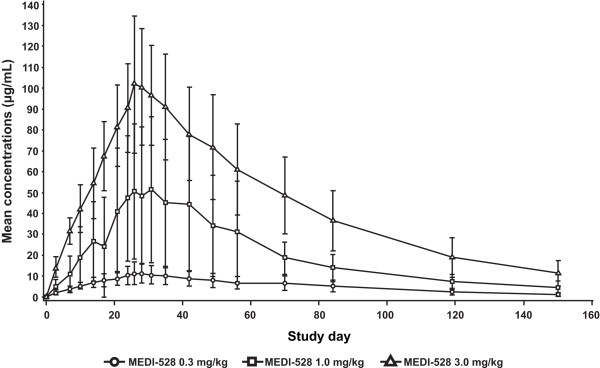
MEDI-528 mean serum concentrations in study 1. Mean maximum concentration after the last dose of 0.3 mg/kg to 3 mg/kg, respectively, mean half-life, trough concentrations after the first and last doses were measured. Mean concentrations of MEDI-528 increased in a dose-proportional manner and peaked after the last dose of the study drug.